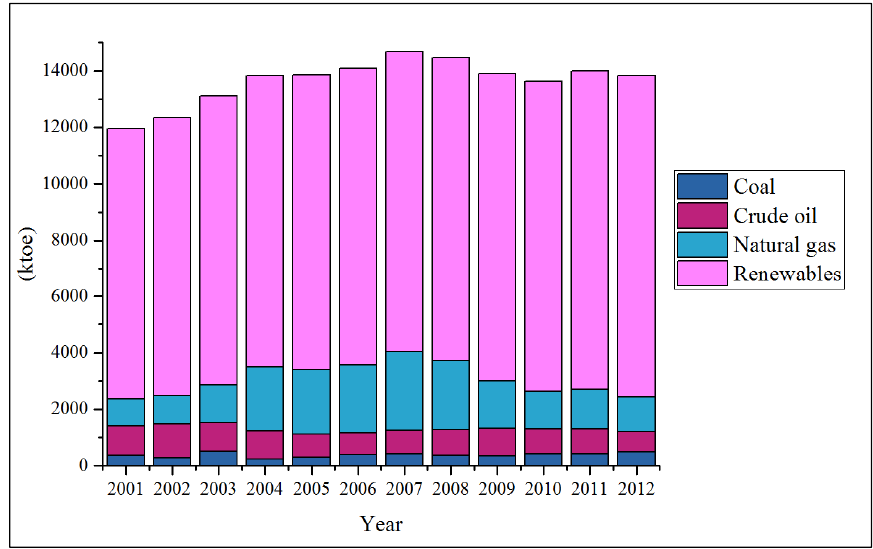
Figure 5. Myanmar: primary energy mix.